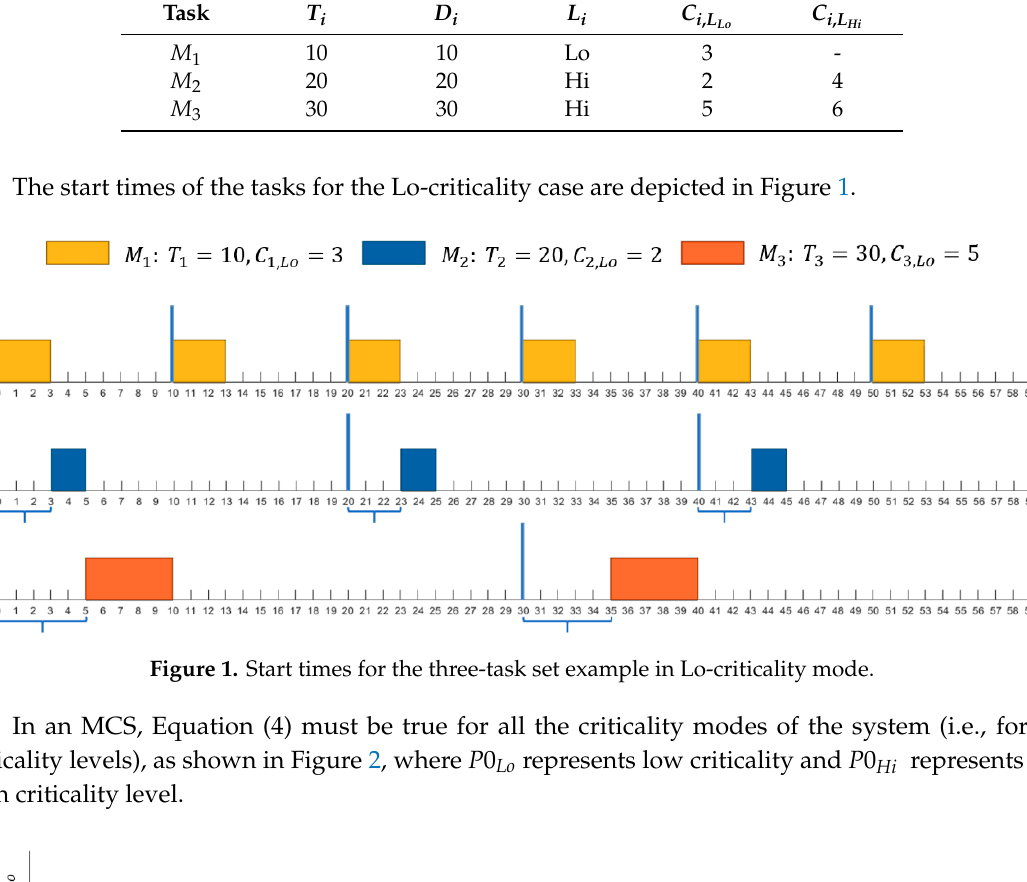
Table 2. Four-task set example.